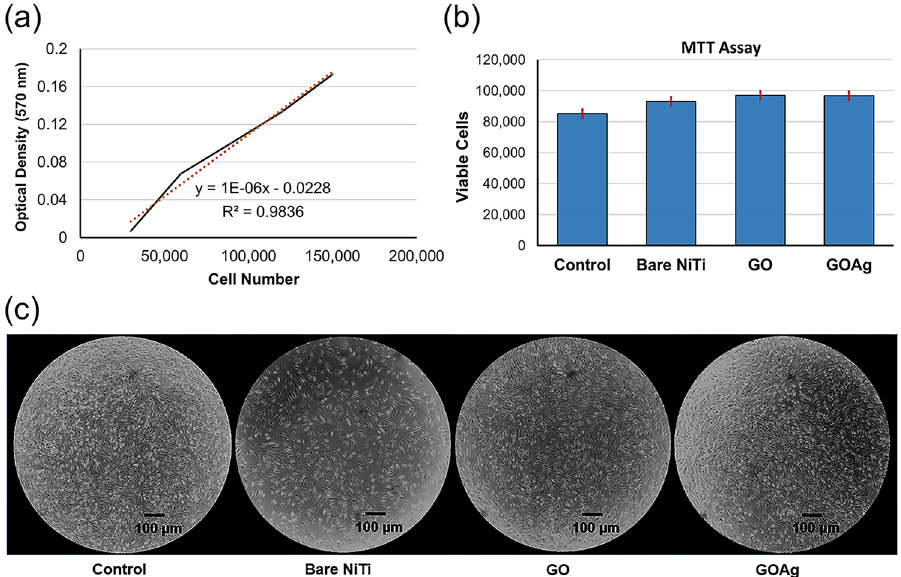
Figure 6. MTT assay of human pulpal fibroblasts. ( a ) Results of the standard curve of cell numbers, ( b ) cell viability, and ( c ) cell morphology visualized in the light microscope (at 20x magnification) of the bare NiTi, GO-coated NiTi (GO), and GO/Ag-coated NiTi (GOAg) alloy after incubating in the conditioned medium with 1% fetal bovine serum (FBS) for 24 hours. There was no significant difference in the viable cells among all the groups (P >